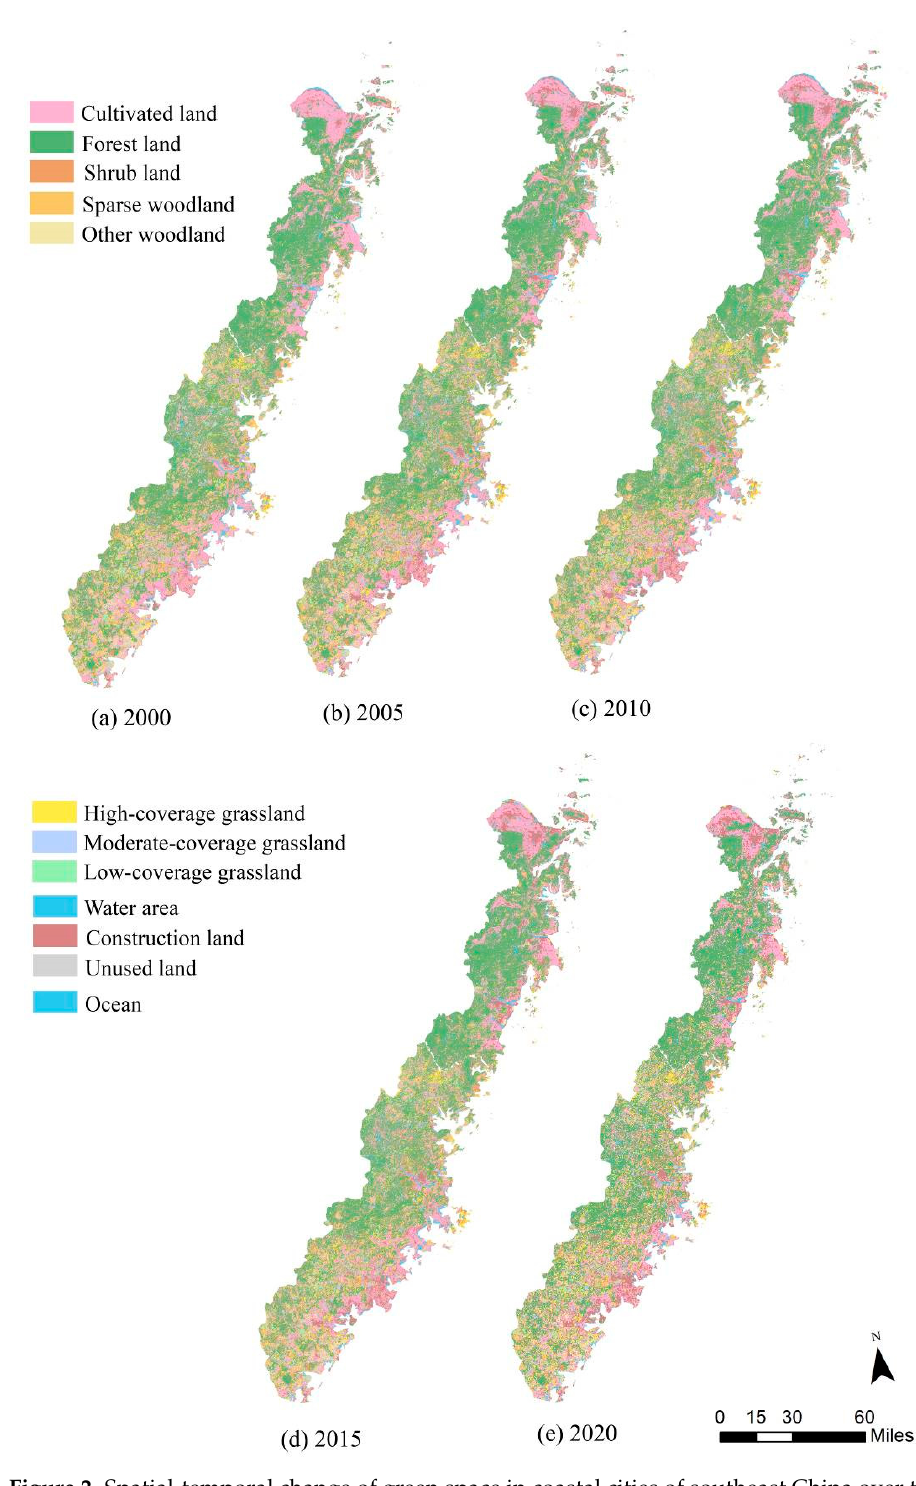
Figure 2. Spatial-temporal change of green space in coastal cities of southeast China over the past 20 years. There are obvious spatial differences in green space over the past 20 years. The spatial change of green space mainly occurred in eastern regions close to the ocean, while inland located in central and western regions were less changed (Figure 2). Additionally, south had larger change of green space than that of north region (Figure 2).